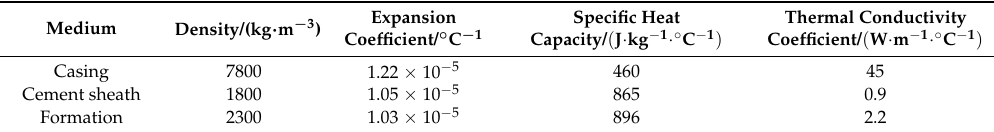
Table 2. Thermodynamic parameters of the